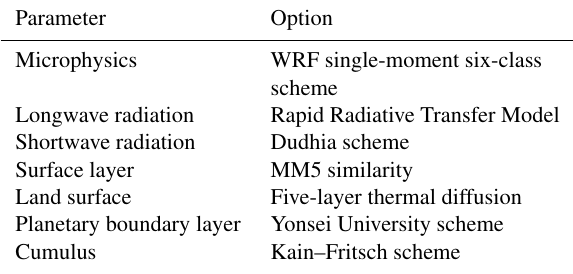
Table 1. WRF physics common to all sensitivity